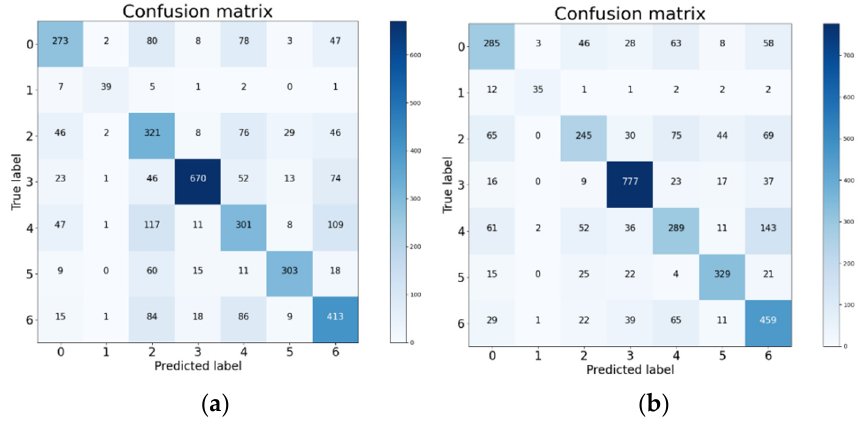
Figure 9. Confusion Matrix. ( a ) VGG16 confusion matrix; ( b ) confusion matrix for the VGG16 model with ECANet added.